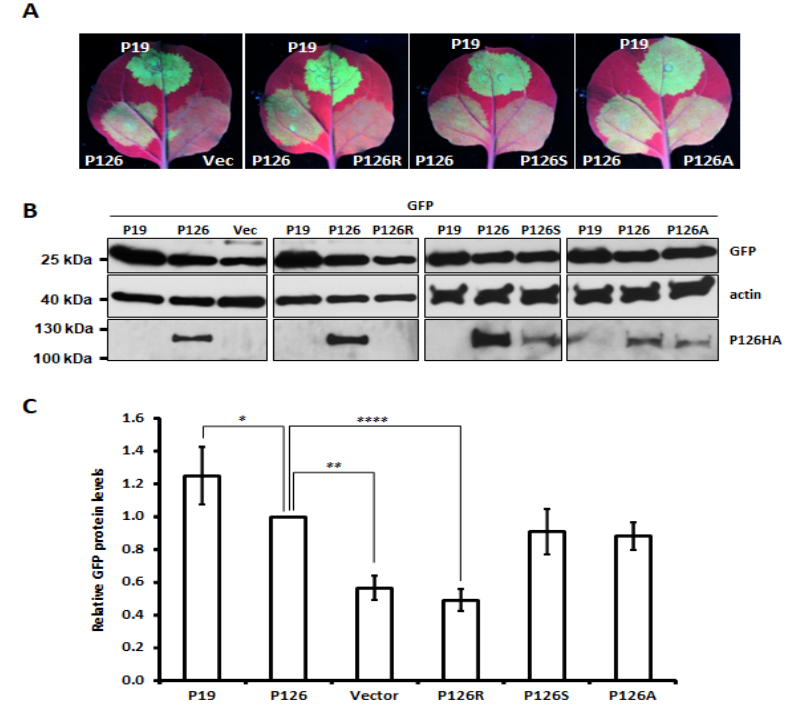
Figure 3. VSR activity of single amino acid substitution mutants of ORSV P126. ( A ) GFP signals upon co-expression with vector control (Vec), P19, P126 and derived P126 mutants. ( B ) Total protein was extracted from the infiltrated leaf discs and then subjected to Western blot in order to detect GFP, actin, P126 and mutant variants. ( C ) Relative GFP protein level was normalized with actin. The GFP level upon co-expression with P126 was set as 1. Vec: vector control. Data represent results from three different experiments. Significant differences are marked as follows: *: p < 0.05; **: p < 0.01; **** p < 0.0001 (one-way ANOVA followed by a post-hoc